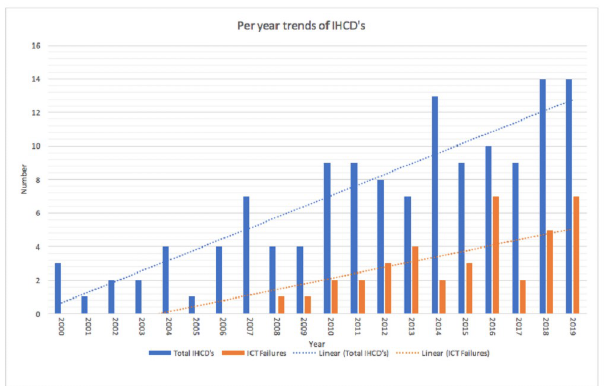
Fig 3. Distribution of total internal hospital crises and disasters and primary ICT failures. Occurrence in the Netherlands by year: 2000–2019 with a linear trend over time.